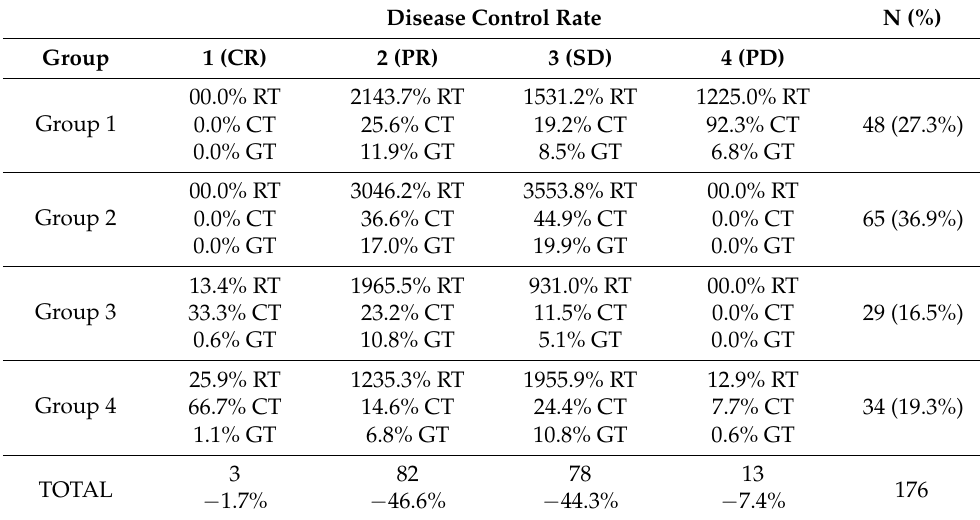
Table 4. Disease control rate (DCR) by analyzed groups of patients.